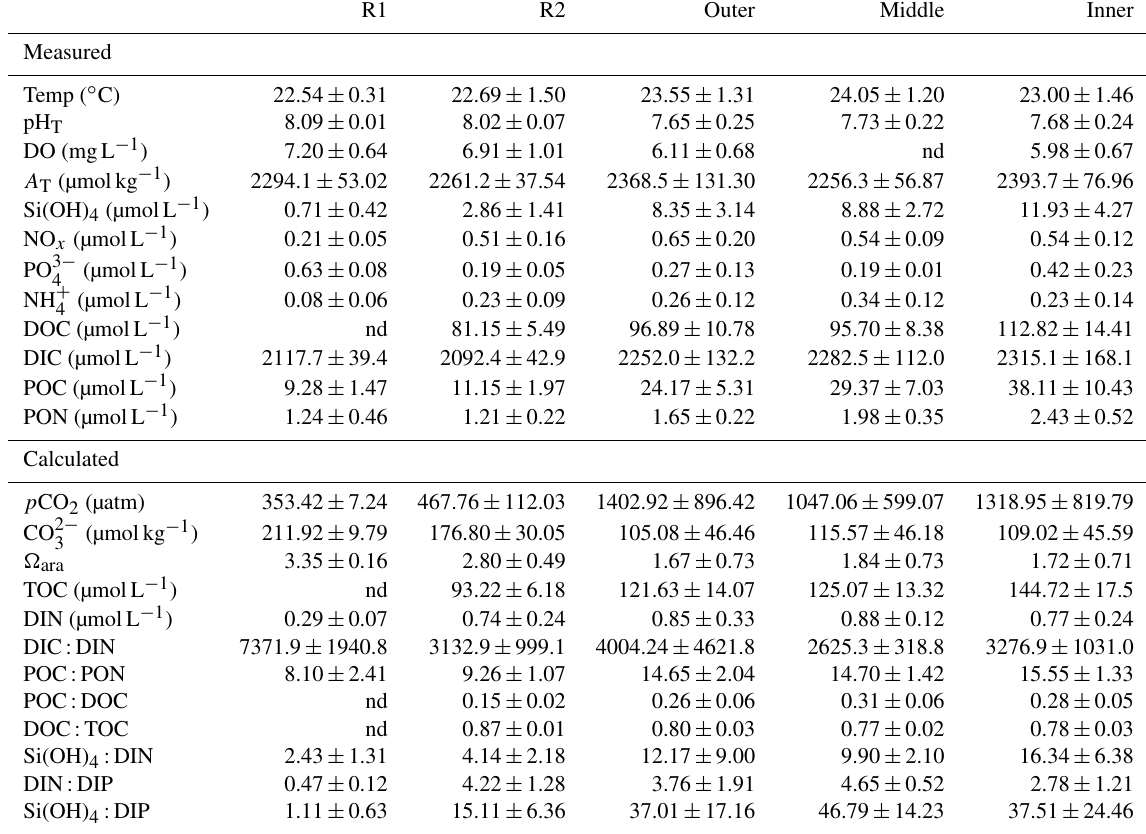
Table 2. Summary of the seawater physical and chemical data (mean ± SD) measured in July 2017 and June 2019 and calculated using the CO 2 SYS package. Data were pooled and averaged per station; nd = not determined. Reference reefs: Sts R1 and R2; Bouraké lagoon stations: outer, middle, and